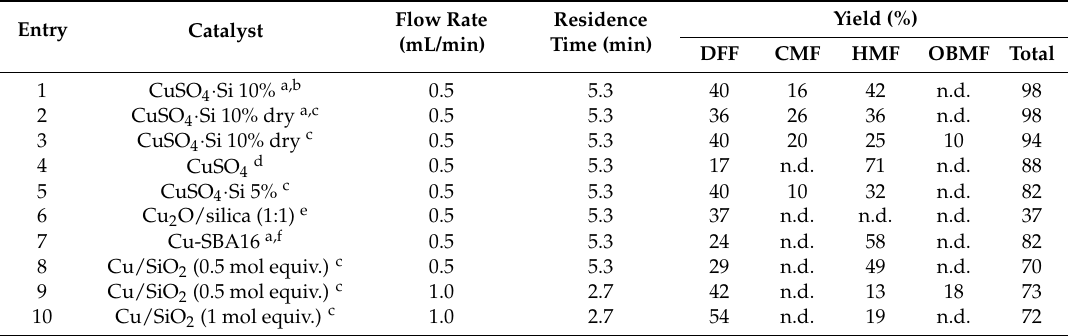
Table 5. Oxidation of CMF under flow conditions using different heterogeneous